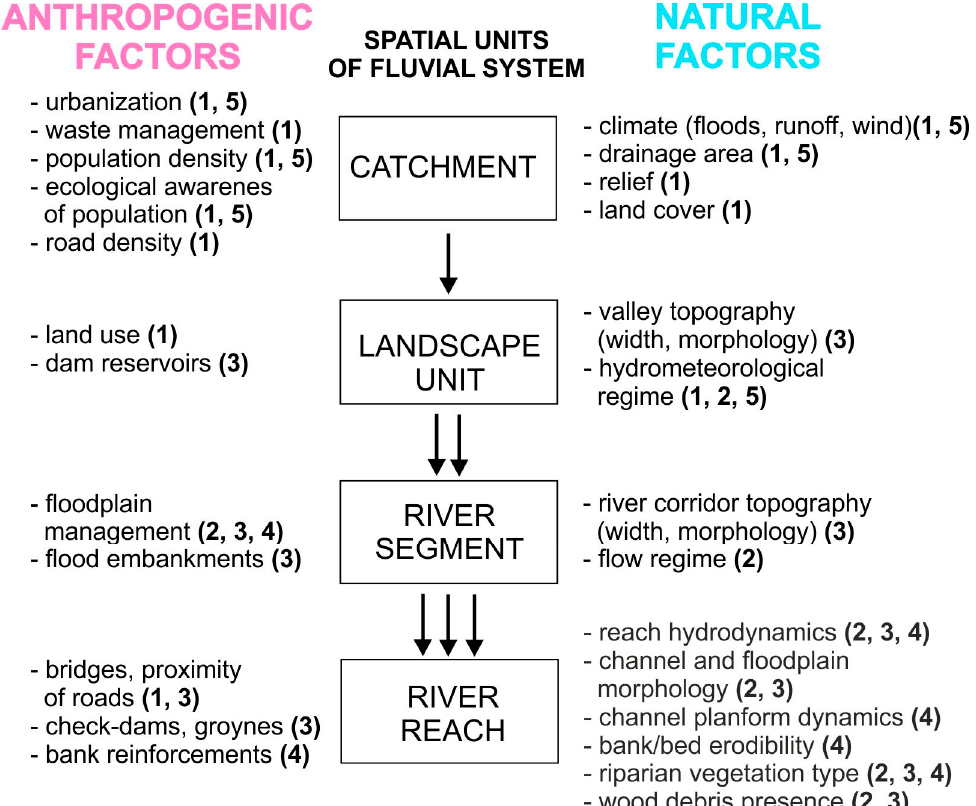
Figure 2. A scheme of anthropogenic and natural factors controlling particular phases of the Figure2. Aschemeofanthropogenicandnaturalfactorscontrollingparticularphasesofthemacroplastic macroplastic route in different spatial units of a fluvial system. 1–input; 2–transport; 3–storage; route in di ff erent spatial units of a fluvial system. 1—input; 2—transport; 3—storage; 4—remobilization; 4–remobilization; 5–output. Arrows indicate the increasing number of controls on the fate of 5—output. Arrows indicate the increasing number of controls on the fate of macroplastic debris from macroplastic debris from larger to smaller spatial units of a fluvial system. larger to smaller spatial units of a fluvial